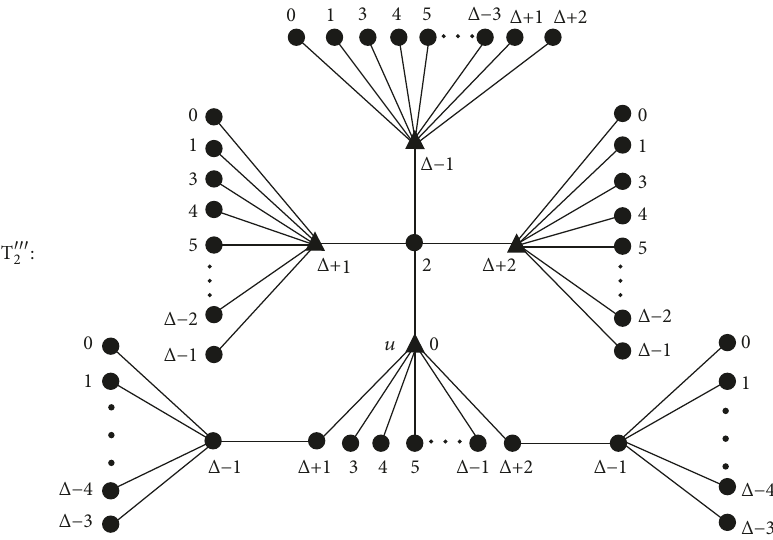
Figure 8: Irreducible 𝐿(2, 1) -span coloring of 𝑇 󸀠󸀠󸀠 2 with Δ as